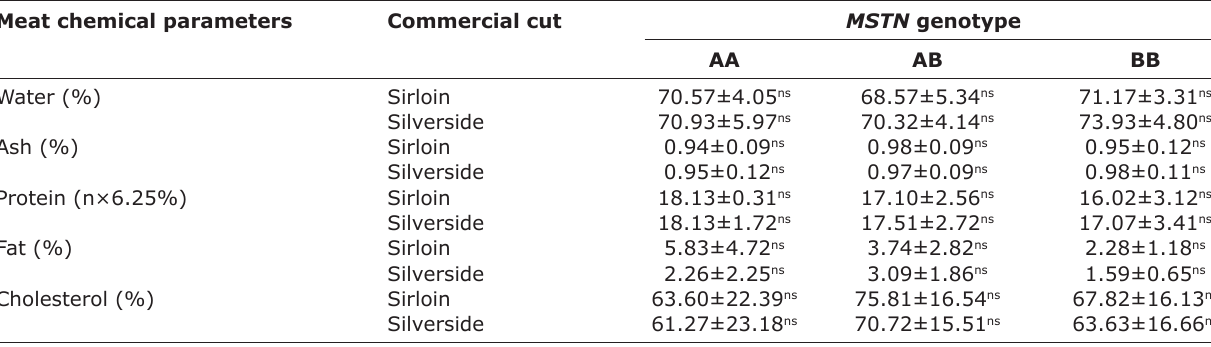
Table-5: Average meat chemical parameters of Aceh cattle with different MSTN genotypes. Meat chemical